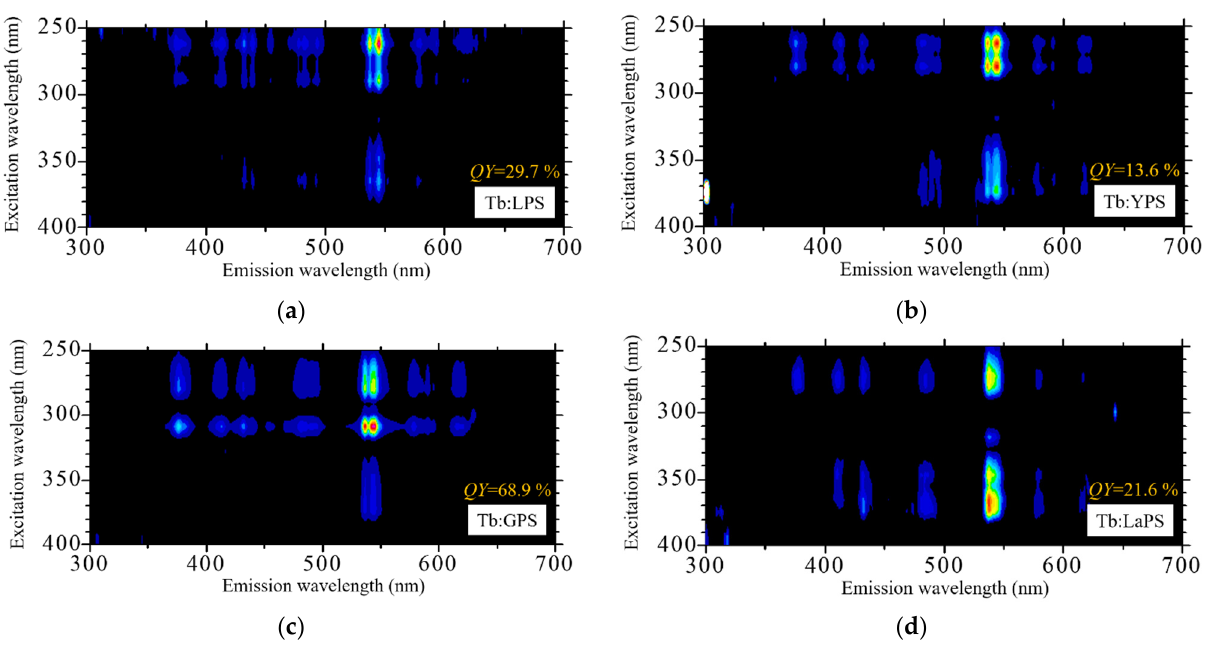
Figure 4. PL excitation and emission contour graph of ( a ) Tb-doped LPS; ( b ) Tb-doped YPS; ( c ) Tb-doped GPS; ( d ) Tb-doped